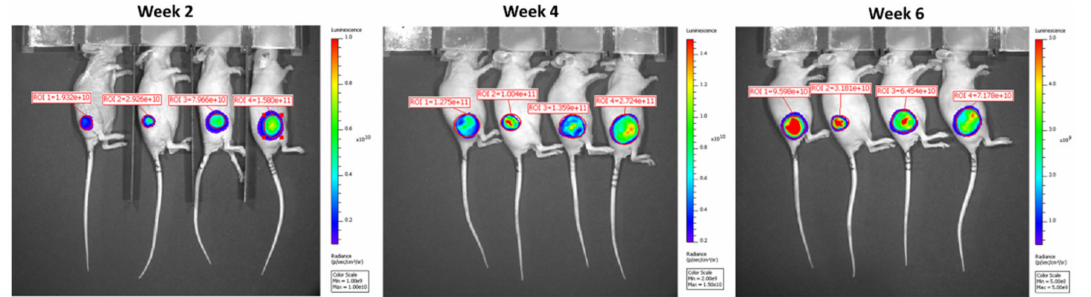
Figure A2. Representative BLI images of Hela/pEF1-Luc2-Sec-miR 8X mice. BLI images were acquired on weeks 2, 4, and 6 after tumor inoculation. Viable cells present in tumors seemed to decrease as the BLI signal reduced on Week 6 after tumor